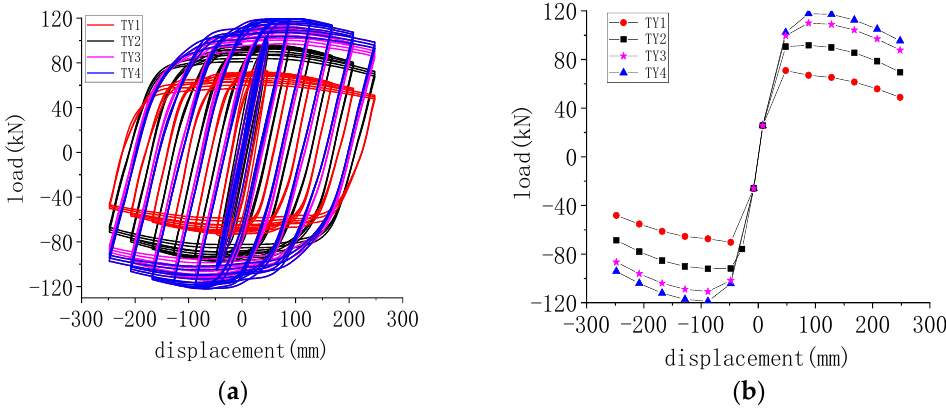
Figure 19. Hysteresis curve and skeleton curve of TY specimen: ( a ) hysteresis curve; ( b ) skeleton curve.